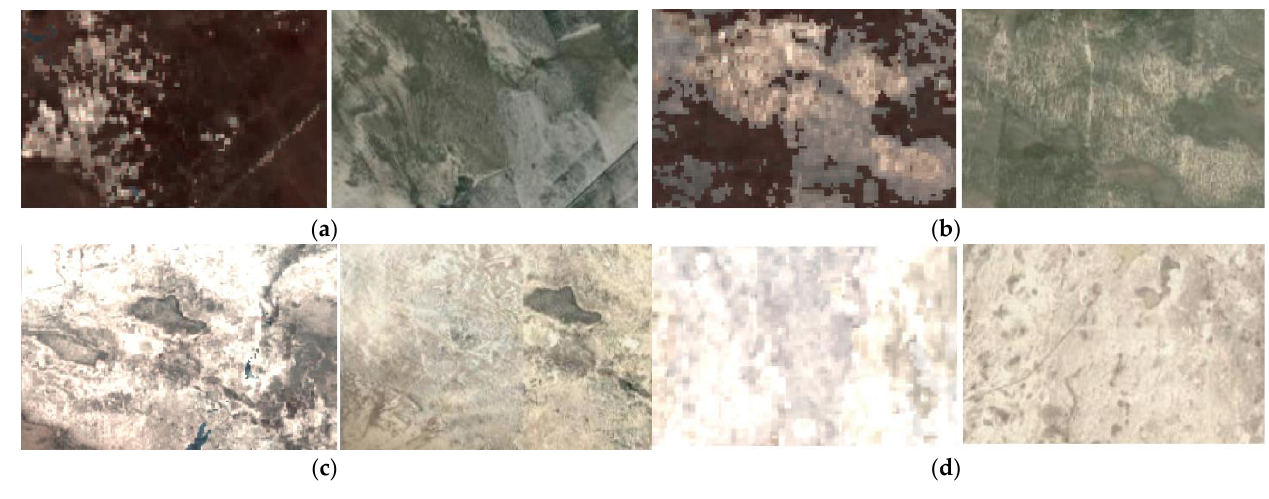
Figure 2. Interpretation marks of desertification in Landsat images (left) and Google images (right). ( a ) Slight desertified land, ( b ) moderate desertified land, ( c ) serious desertified land, and ( d ) very serious desertified land.